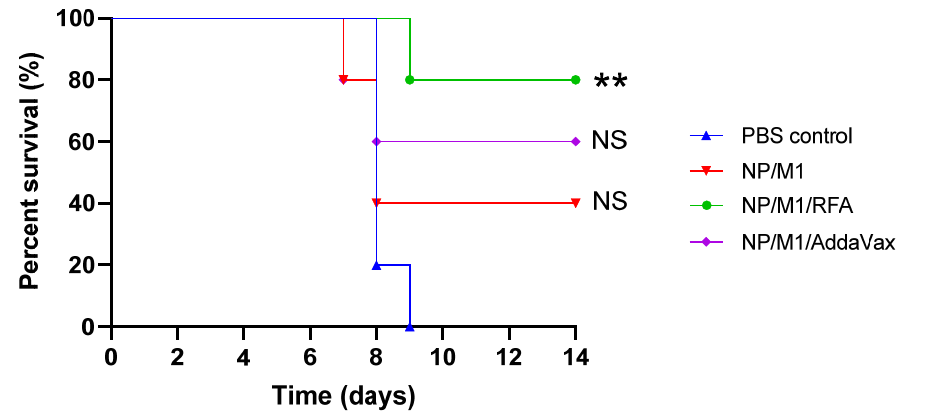
Figure 6. Protection against lethality after lethal viral challenges. Survival of virus-challenged mice was monitored for 14 days. Mice were regarded as dead if their body weight loss was more than 20%. n = 5. Log-rank (Mantel-Cox) test was used to compare differences of survival between PBS control and other groups. **, p < 0.01. NS: not